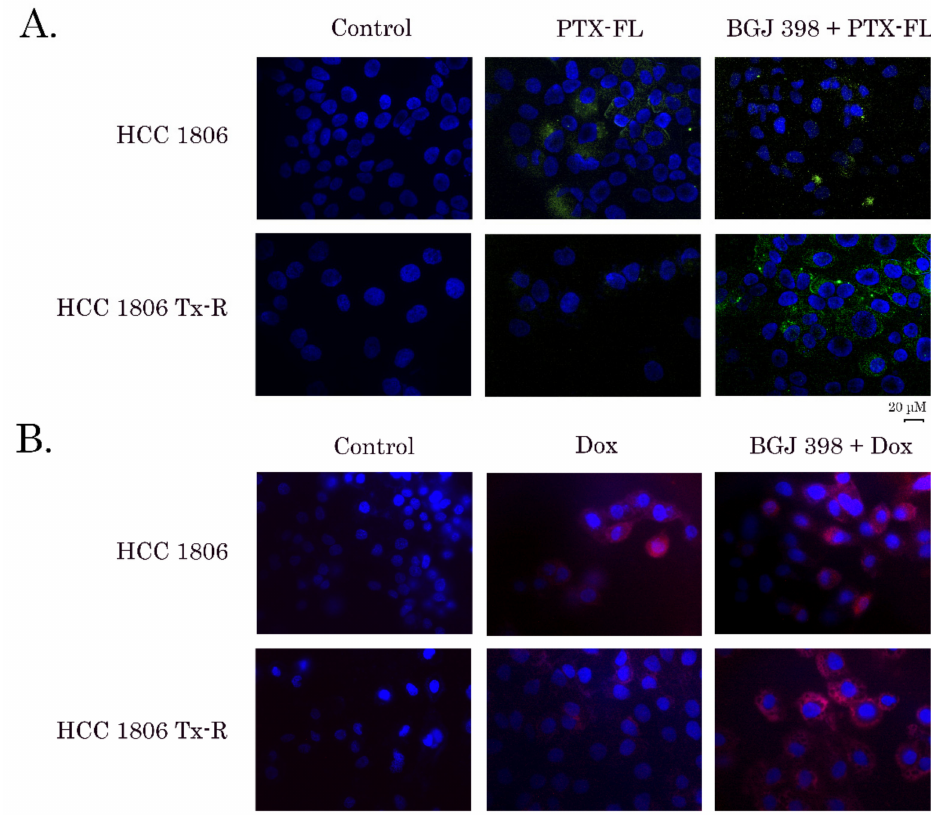
Figure 2. Fluorescence microscopy analysis of the intracellular accumulation of Flutax-2 (PTX-FL) ( A ) and doxorubicin (DOX) ( B ) in HCC 1806 parental (upper panels) and Tx-R (lower panels) cells. The cells were first incubated with BGJ 398 (20 µ M) (right) or DMSO as a control (middle) for 60min and then incubated with 3 µ M PTX-FL ( A ) or 40 µ M DOX ( B ) for an additional 60 min. After the wash-out with a pre-warmed FBS-free culture medium, the BGJ 398-treated cells were additionally incubated with BGJ 398 for 60 min. The non-fixed slides were counterstained with Hoechst 33342 (final concentration 3 µ g/mL) for 5 min to outline the nuclei and processed for fluorescence microscopy to obtain the merged